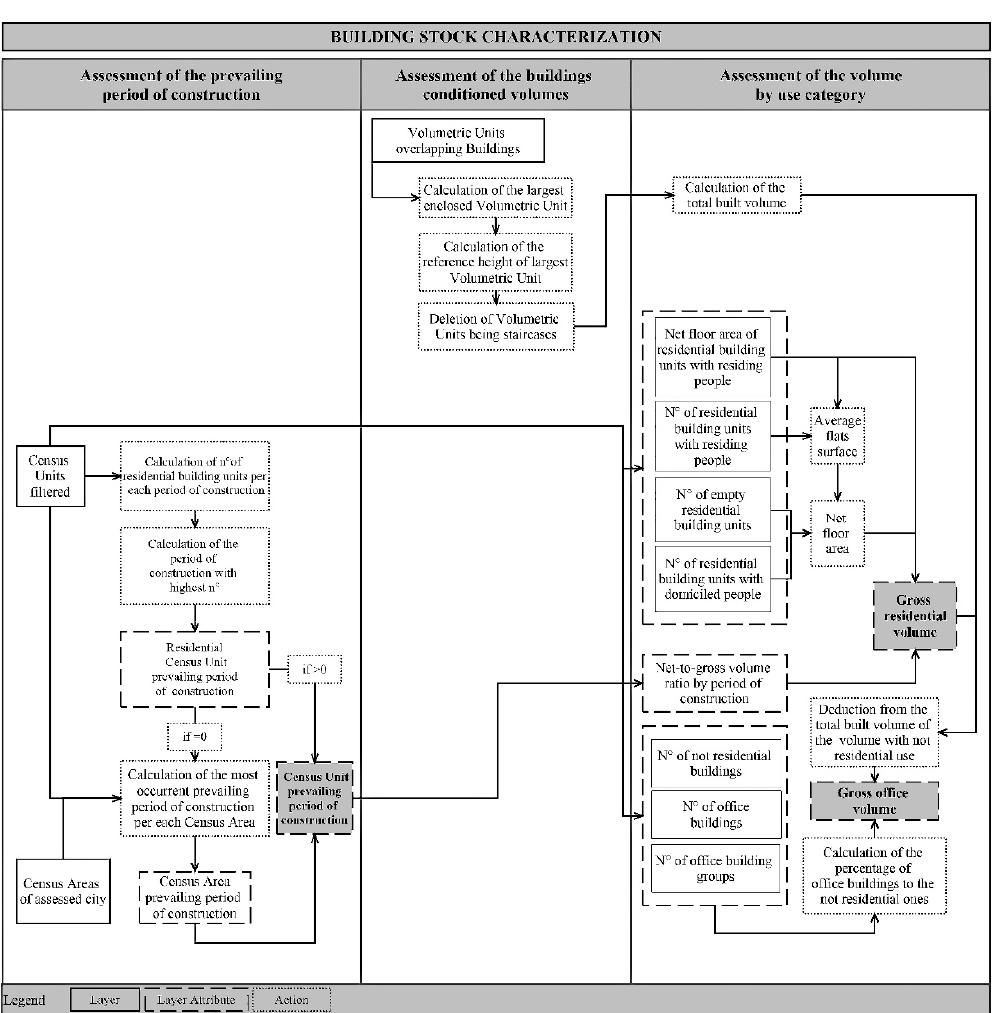
Figure 3. Census Unit association based on Buildings’ centroids.